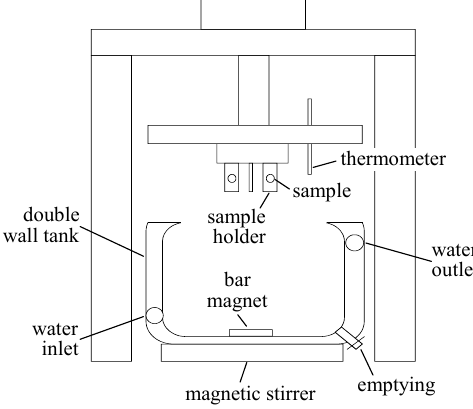
Figure 2. Schematic view of electroless NiP experimental reactor.